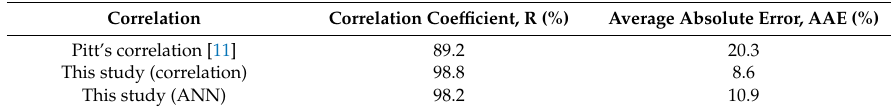
Figure 6. Cross-plot of the (measured) experimental and predicted apparent viscosity from the Pit's [11] correlation. Table 3. The statistical accuracy of the developed correlation, literature correlation and artificial neural network (ANN) model.